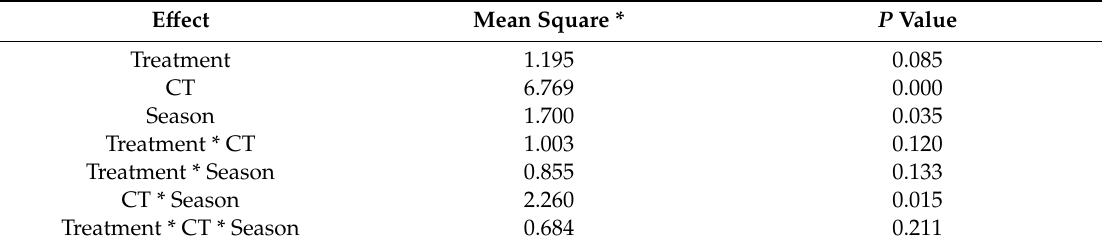
Table 2. ANOVA table comparing the main- and interaction e ff ects of treatment (R, F, GAC), CT, and season on the formation of NDMA in Bailey Brook source water. E ff ect Mean Square * P Value 1.195